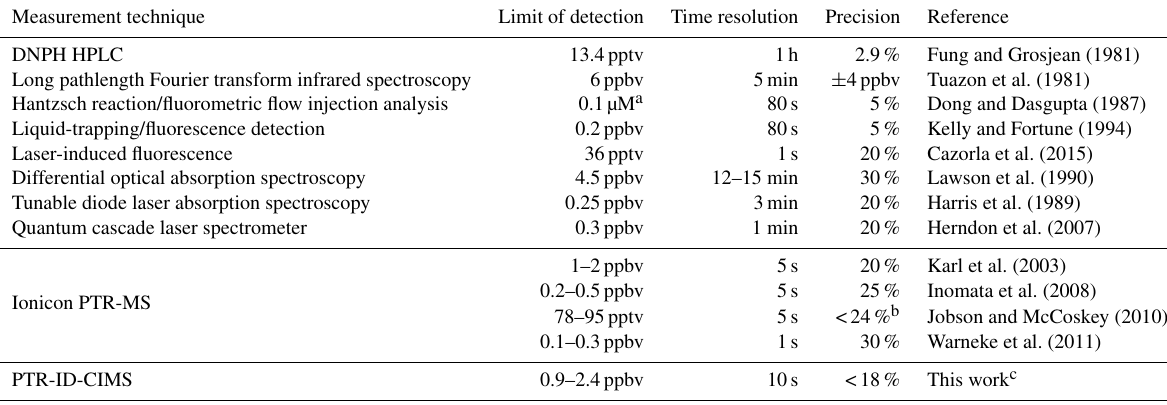
Table 1. Performance intercomparison of various HCHO measurement techniques.